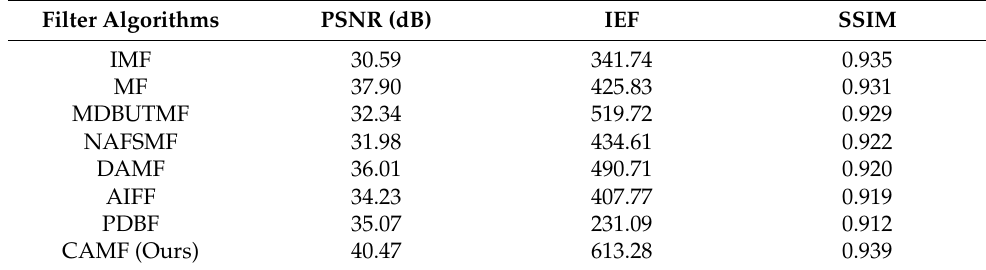
Table 1. Comparison of image processing effect between CAMF and the above filtering algorithms. Filter